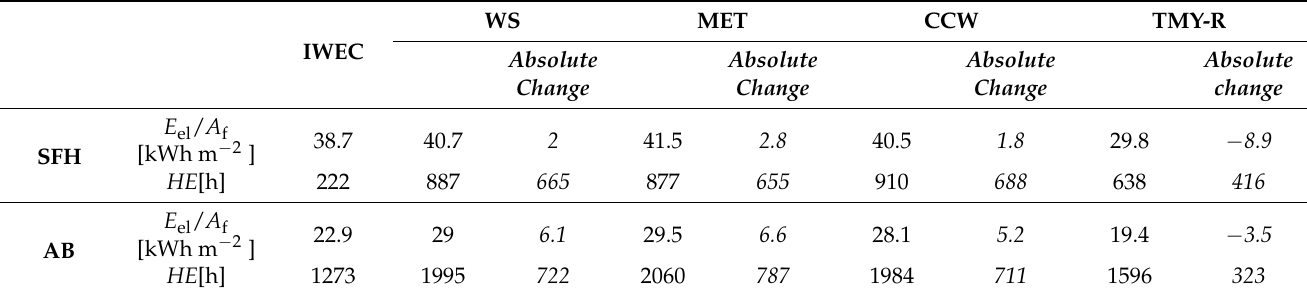
Table 1. Electrical energy demand per unit of area and hours of exceedance for a mono family house (MFH) and apartment block (AB), for IWEC (Present), Weathershift (WS), Meteonorm (MET), CCWorldWeatehr-Gen (CCW), and F-TMY. All future weather files are for 2050s considering RCP 8.5.